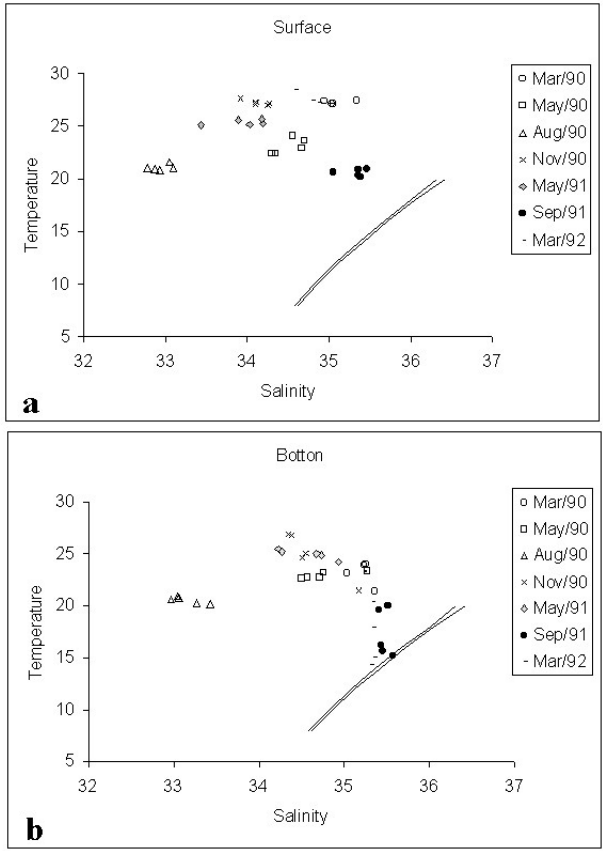
Fig. 2 . T-S diagram for the Mamanguá Inlet based on (a) sur- face and (b) bottom data of temperature and salinity from March 1990 to March 1992. Lines represent the values of the South Atlantic Central Waters, calculated from coefficients of the mean T-S expressions based in Miranda (1985).